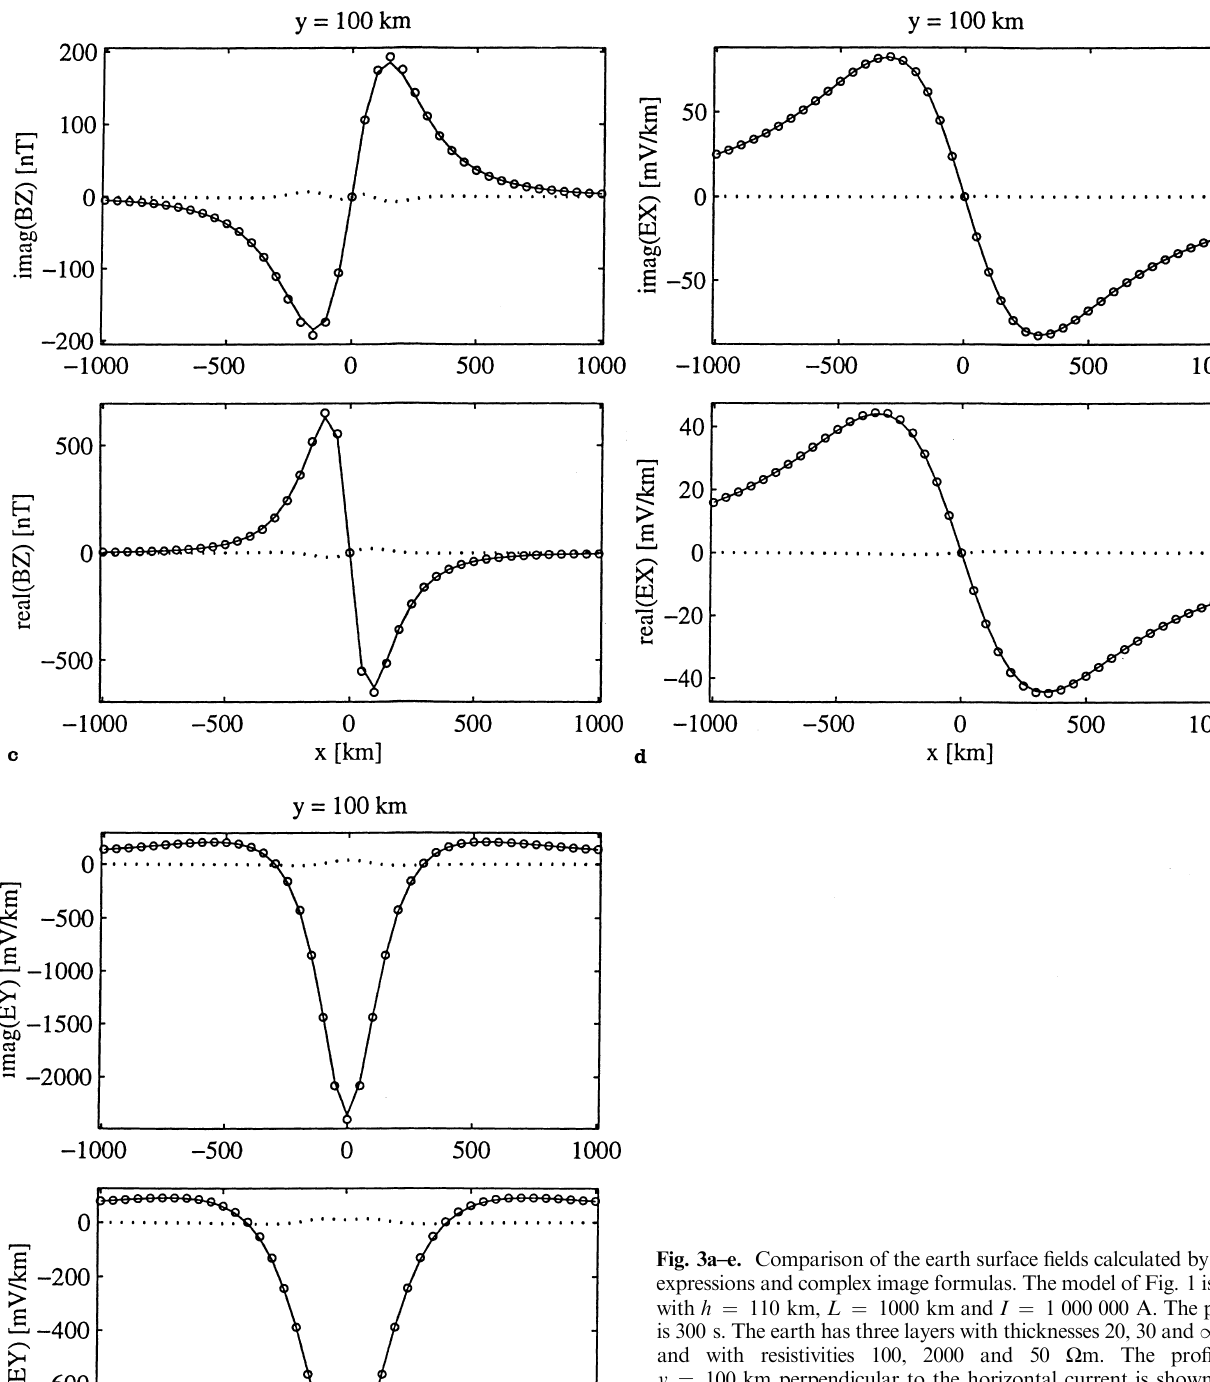
Fig. 3a–e. Comparison of the earth surface fields calculated by exact expressions and complex image formulas. The model of Fig. 1 is used with h (cid:136) 110 km, L (cid:136) 1000 km and I (cid:136) 1 000 000 A. The period is 300 s. The earth has three layers with thicknesses 20, 30 and 1 km, and with resistivities 100, 2000 and 50 W m. The profile at y (cid:136) 100 km perpendicular to the horizontal current is shown. The real and imaginary parts of the field components are depicted separately. a magnetic x component, b magnetic y component, c vertical magnetic component, d electric x component, e electric